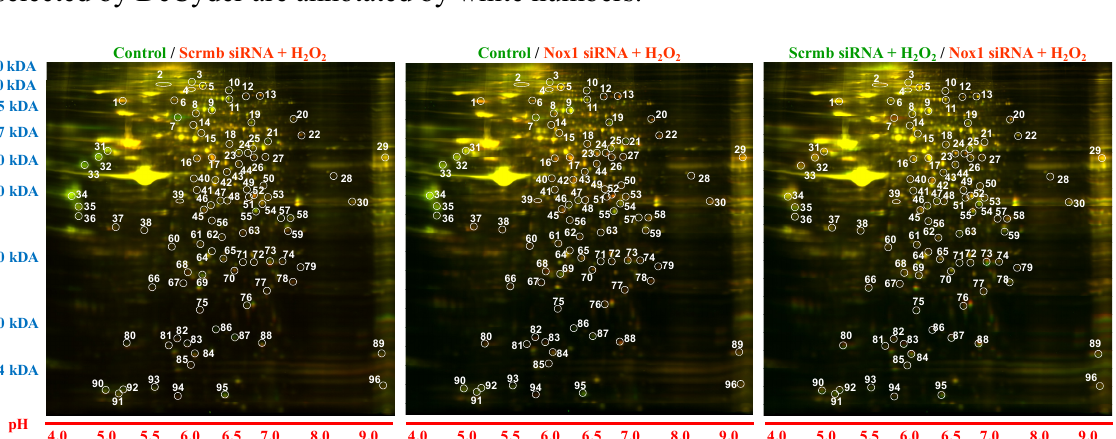
Figure 1. Representative 2D gel images. Vascular smooth muscle cells (VSMC) incubated with vehicle (control) or transfected with Scrmb or Nox1 siRNA and treated with H (50 μ M, 3 h) were lysed and fluorescently labeled with Cy3, Cy2, or Cy5, respectively and run on a 2D gel ( n = 1). Images show the comparisons of two fluorescent channels at a time (assigned green and red pseudocolors) as presented in Table 1. Vertical scale indicates the molecular weight ladder; lower horizontal scale denotes pH gradient. The 96 gel spots selected by DeCyder are annotated by white